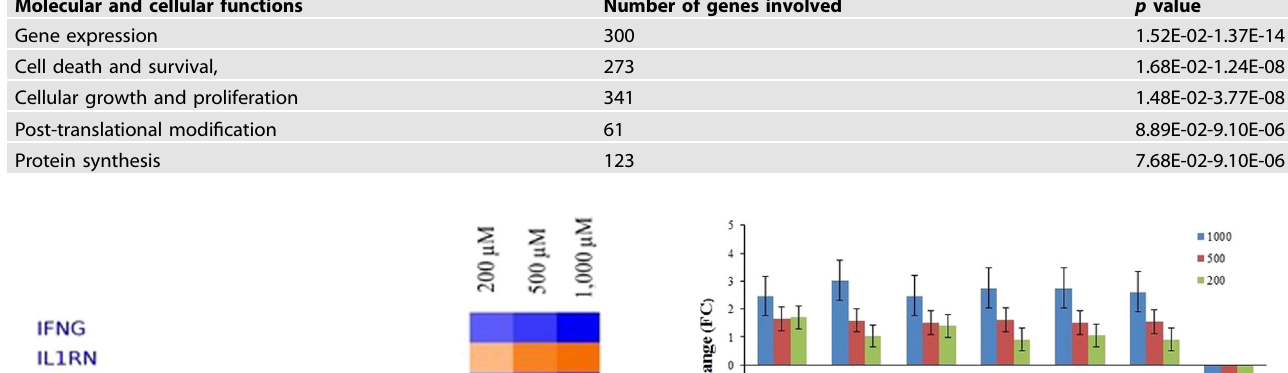
Table 5. Top fi ve MCFs predicted by Ingenuity Pathway Analysis (IPA) that were corresponding to 1000 μ M treatment ( p < 0.05). Molecular and cellular functions